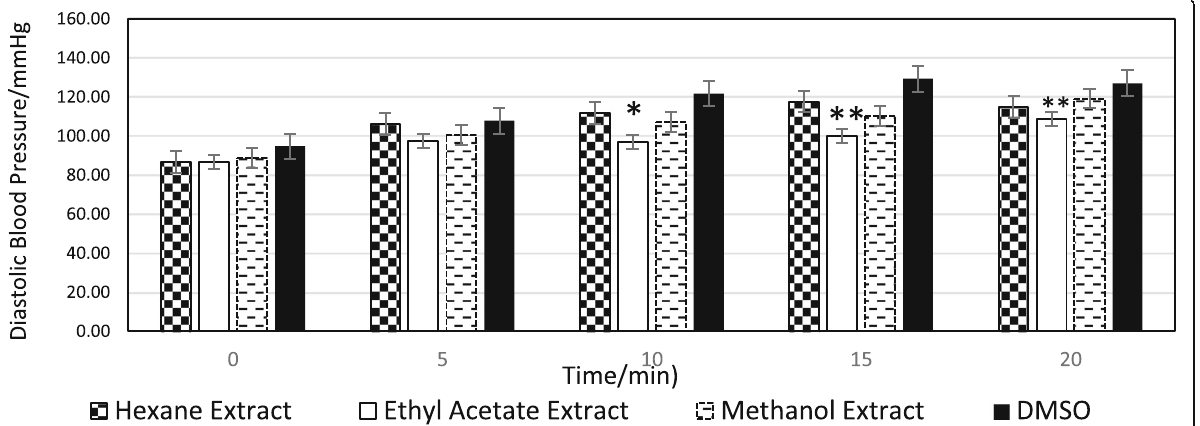
Fig. 4 The effects of the crude extracts of D. canum on the diastolic blood pressure of normal Sprague-Dawley rats (IV @ 50 mg/kg BW). * p < 0.05. ** p < 0.01